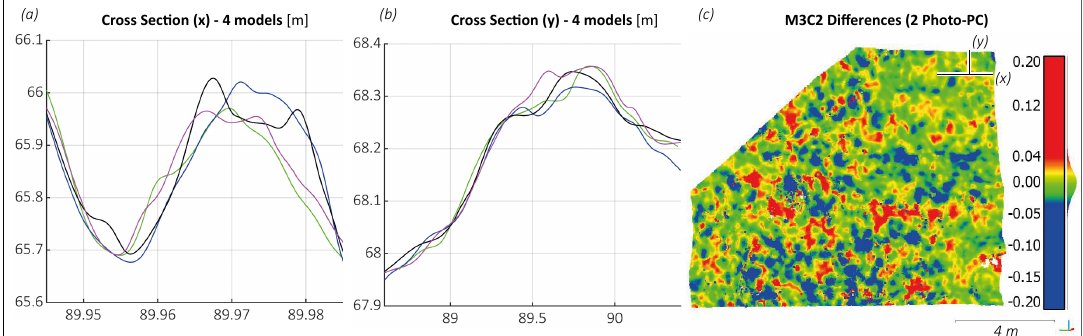
Figure 6. ( a ) X cross-sections of four Photo-PCs generated using five images (each color corresponds to a di ff erent Photo-PC). ( b ) Y cross-sections of four Photo-PCs generated using five images (each color corresponds to a di ff erent Photo-PC). ( c ) Distribution of di ff erences of two Photo-PCs computed by M3C2. (x) and (y) shows the cross section represented in ( a ) and ( b ).